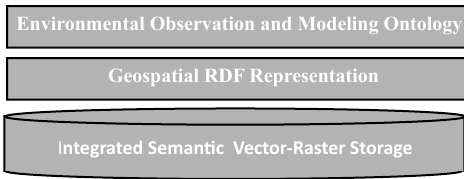
Figure 7. Illustration of challenges towards smart environmental data and metadata representation and